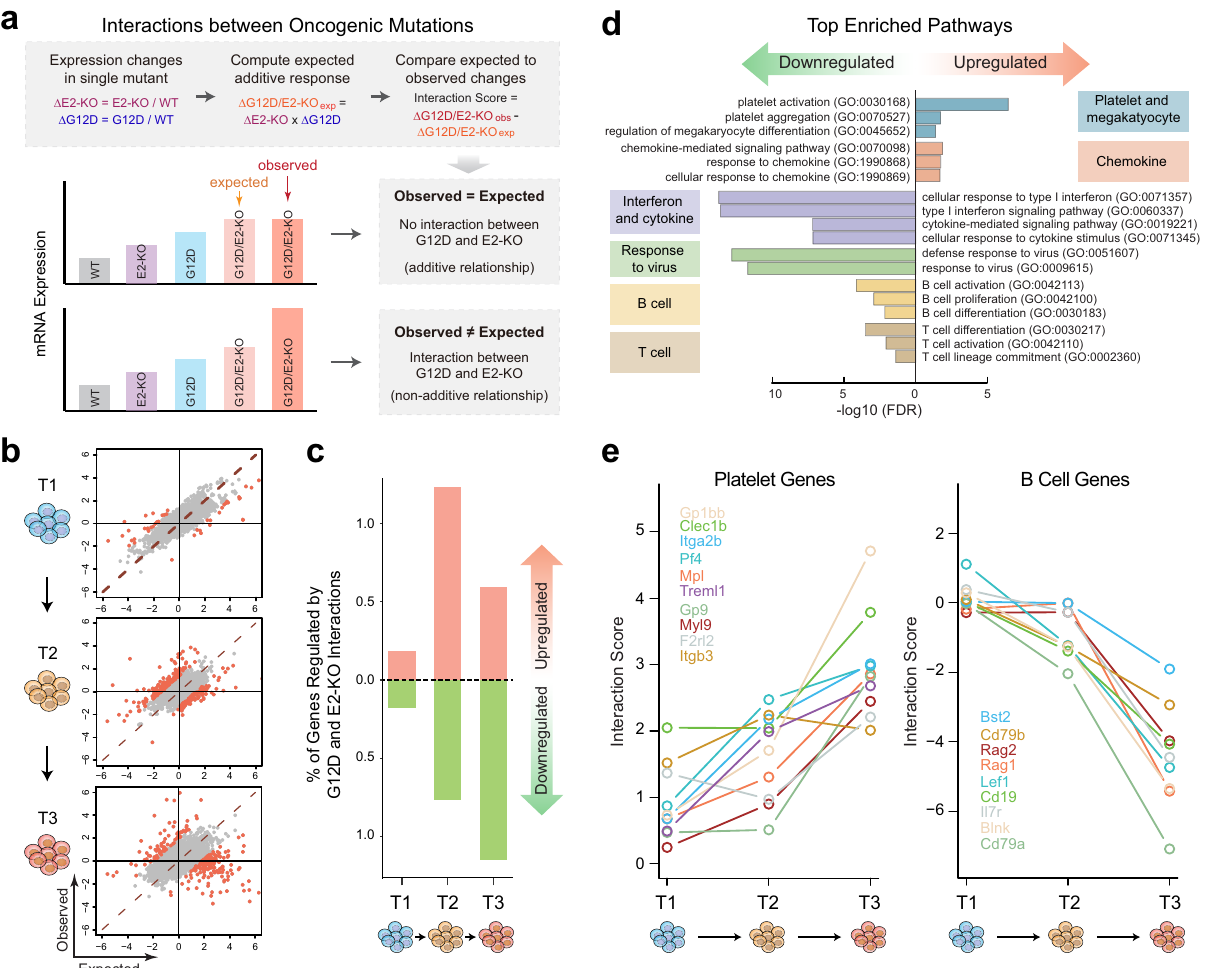
Fig. 5 Synergistic regulation of gene expression by cooperating oncogenic drivers in leukemia-initiating cells. a Schematic of the analysis of interactions between E2-KO and G12D based on the observed and expected gene expression changes in HSPCs containing single or double mutations. b Scatter plots are shown for the observed and expected gene expression changes in G12D/E2-KO HSPCs at three-time points (T1 – T3). Each dot represents a single gene. Red dots indicate signi fi cantly perturbed genes by the interactions between G12D and E2-KO. c The frequencies of genes regulated by G12D and E2-KO interactions are shown at each time point. Upregulated genes were affected by the synergistic interactions of G12D and E2-KO, whereas the downregulated genes were affected by the antagonistic interactions of G12D and E2-KO. d The top enriched functional pathways regulated by G12D and E2-KO interactions. The y -axis shows the GO terms for the enriched pathways, and the x -axis shows the negative log10 (FDR). e Interaction scores for platelet ( left ) and B cell genes ( right ) at different time points in G12D/E2-KO HSPCs are